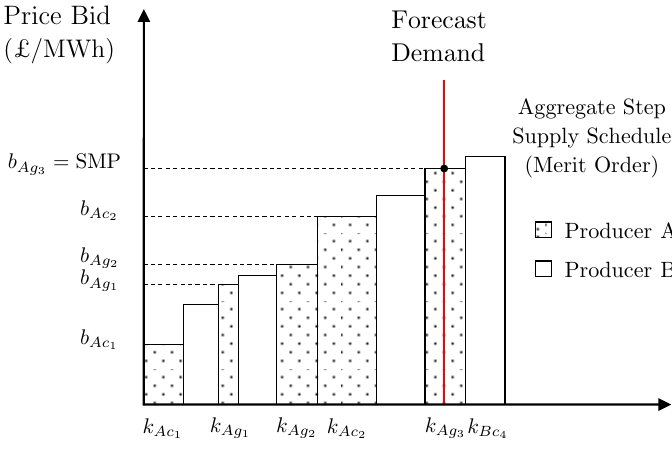
Figure 4. Determination of a System Marginal Price (SMP). Notes: On the vertical axis, b Ac price bid of electricity producer A ’s first production unit, whose production capacity is k Ac sake of simplicity, it is assumed that electricity producer A has 2 coal and 3 gas production unit types. Price bids of all production units are ordered as would have been done by the market operator (i.e., the NGC). The intersection of the constructed production schedule and forecast demand determines the SMP, the wholesale electricity price. In this hypothetical example, it is electricity producer A ’s third gas production unit that determines the